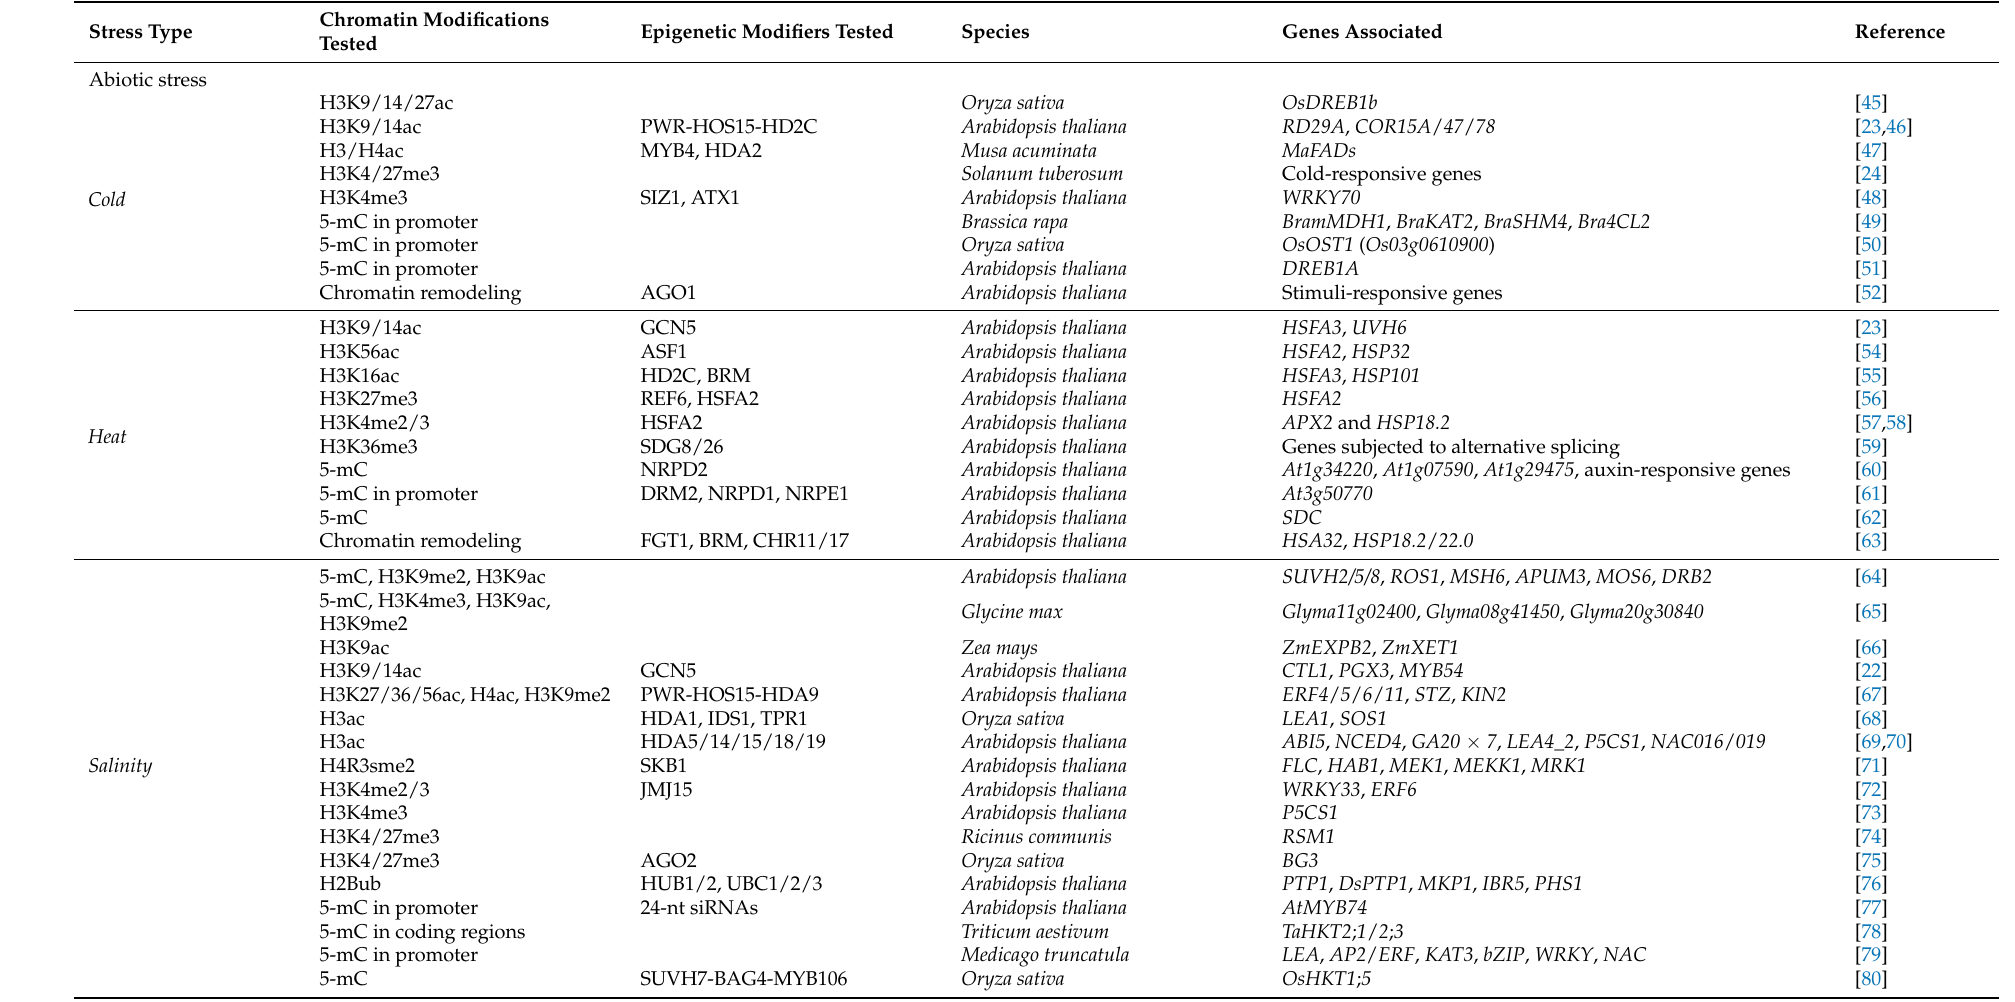
Table 1. Chromatin dynamics (histone modifications and DNA methylation changes) associated with abiotic stress-induced gene expression in